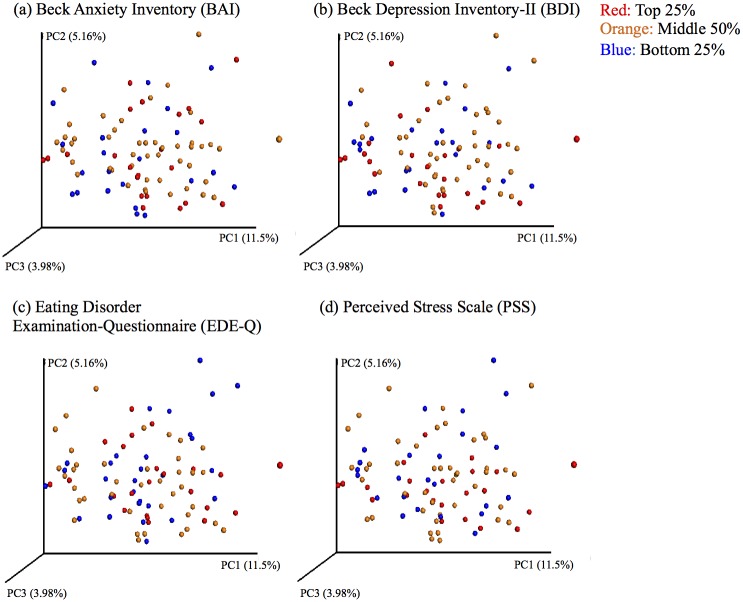
Principal coordinate plots of psychiatric measures by quartile.Principal coordinates were generated using unweighted UniFrac distances from the QIIME pipeline and allocated to quartiles (red: top quartile; orange: middle two quartiles; blue: bottom quartile) based on scores from the (a) Beck Anxiety Inventory; (b) Beck Depression Inventory-II; (c) Eating Disorder Examination-Questionnaire; and (d) Perceived Stress Scale. Plots are based on the first three principal coordinates, which explain 11.5% (PC1), 5.16% (PC2), and 3.98% (PC3) of the variance in microbial composition, and do not cluster by quartile—supporting a lack of association between microbial markers and these psychiatric measures in healthy individuals.